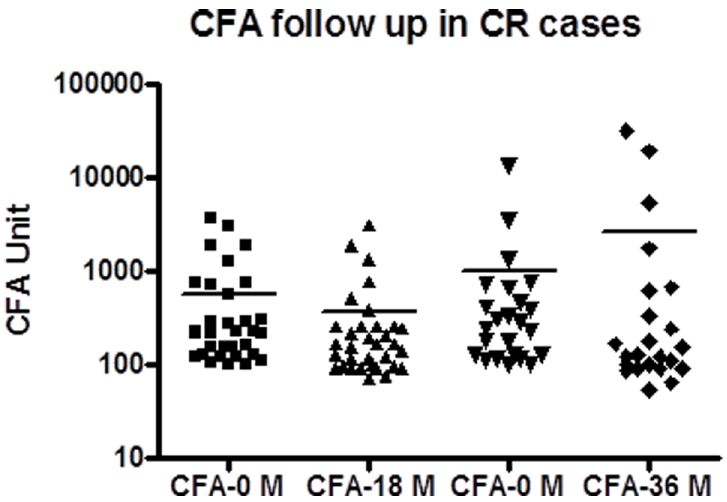
Fig 1. Comparison of CFA between AS and CR cases. CFA levels of 30 asymptomatic Mf carriers and 31 cryptic individuals were taken in to consideration for comparison. They are age sex matched and other parameters has been taken care as narrated in the Table 2.